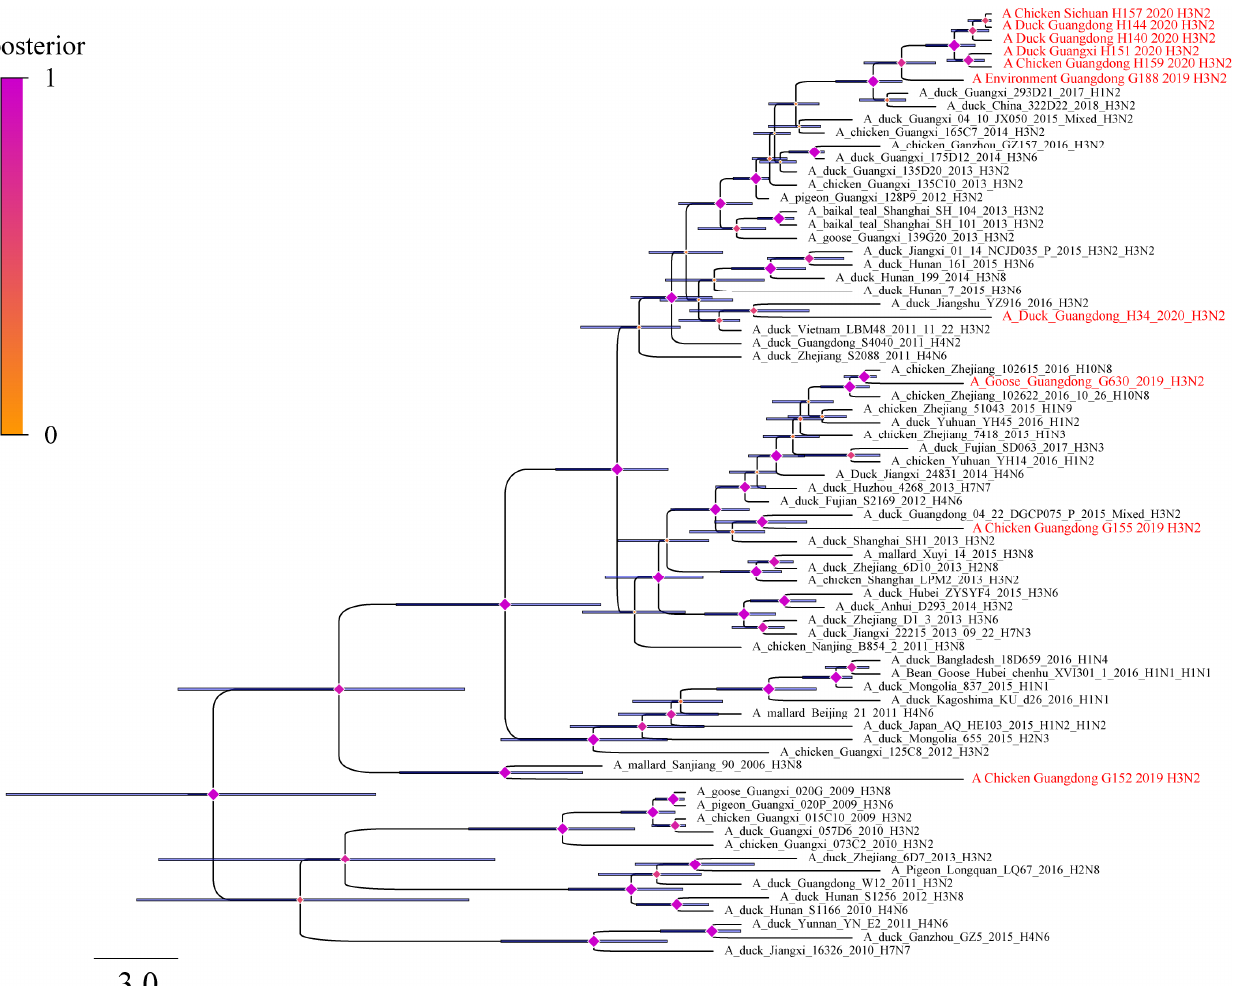
Figure 3. Bayesian Markov chain Monte Carlo method tree of MP gene of isolated H3N2 avian influenza viruses. Blue node bars represent 95% credible intervals of lineage divergence times, and diamonds represent posteriors of every node. The sequence of H3N2 viruses isolated in this study are in red, and viral sequences named in black were downloaded from the databases.